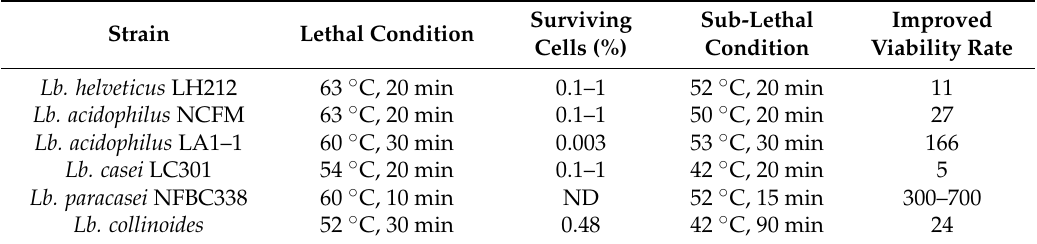
Table 1. Effect of sub-lethal temperature conditions on survival and heat tolerance to lethal temperature in Lactobacillus ( Lb. ) strains during the exponential growth phase review by De Angelis